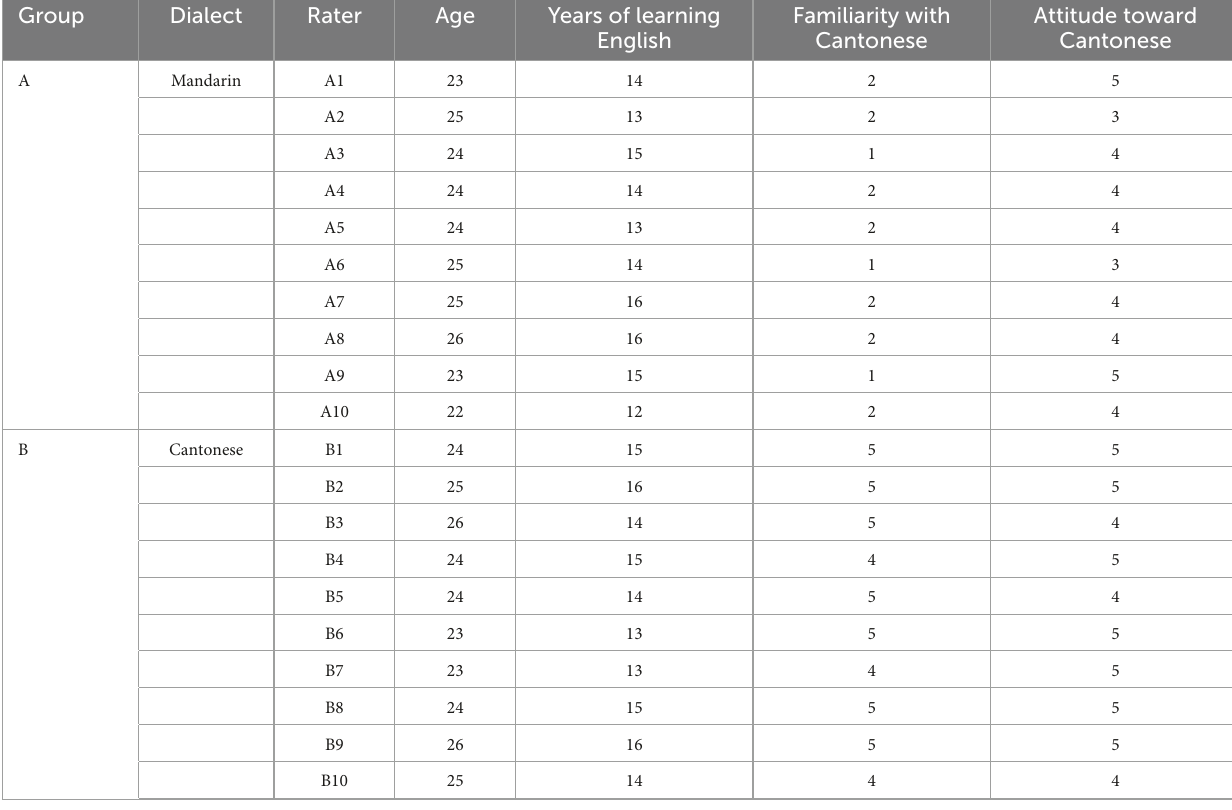
TABLE 1 Raters’ background information.